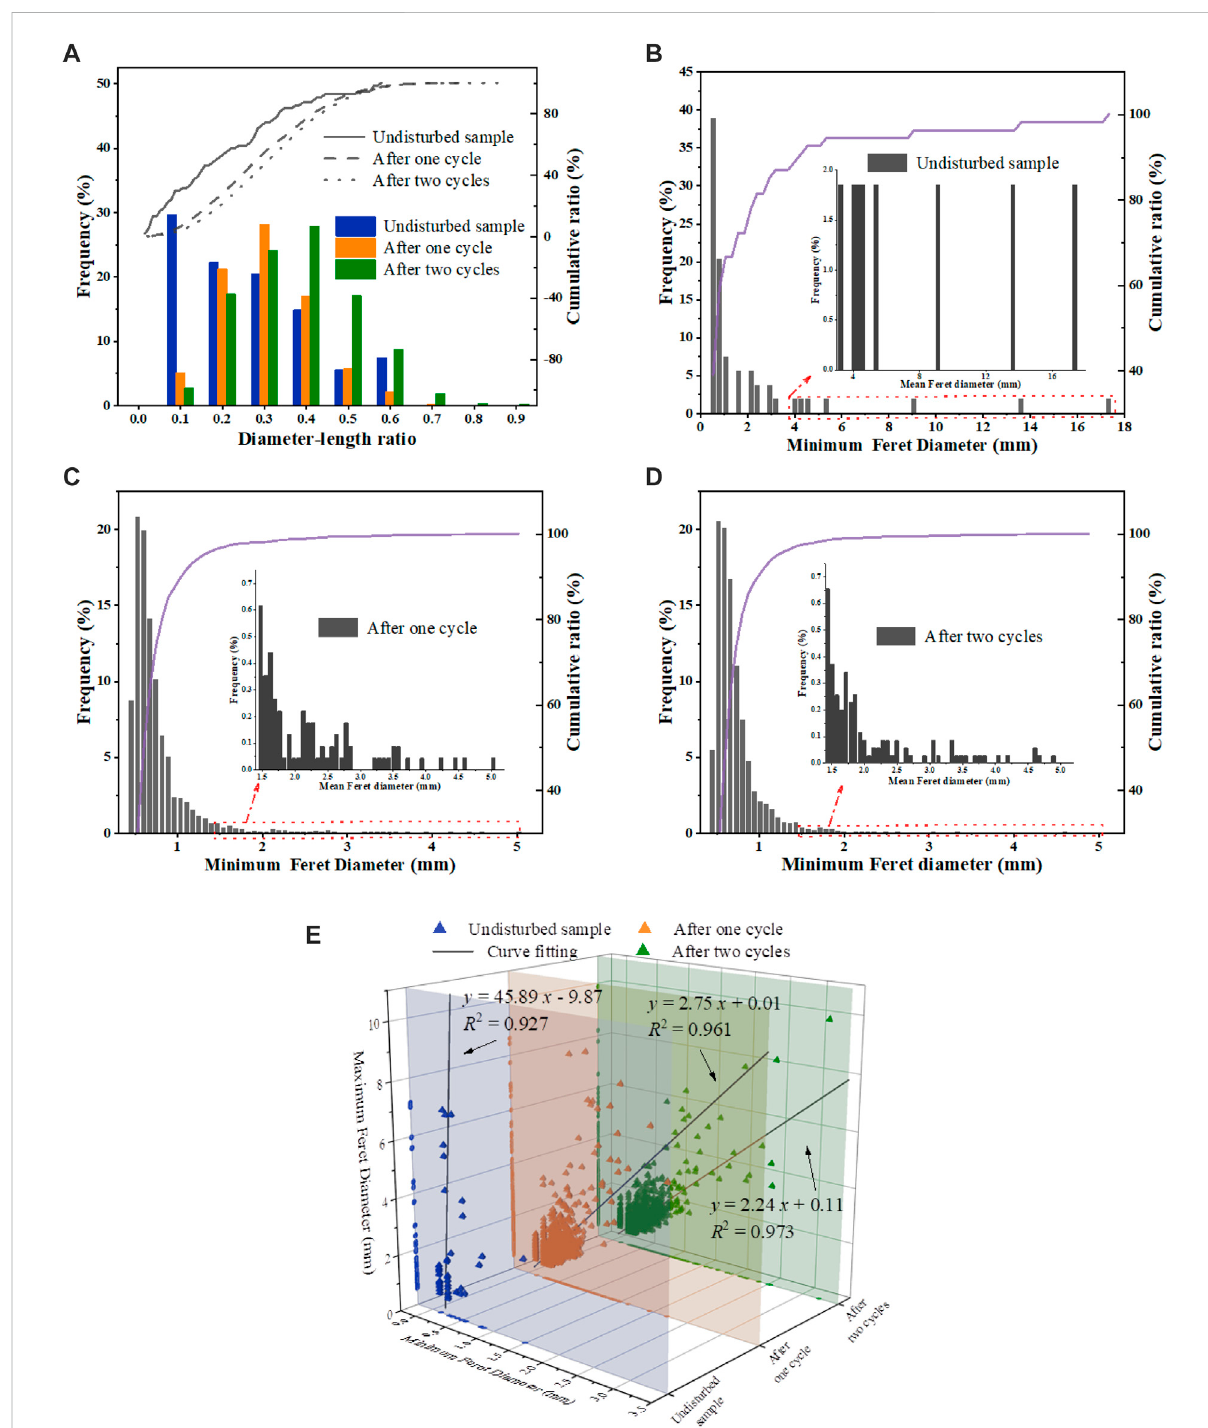
Statistics of geometric parameters. (A) Changes of diameter-length ratio; (B) Minimum Ferret diameter of undisturbed sample; (C) Minimum Ferret diameter after one cycle; (D) Minimum Ferret diameter after two cycles; and (E) Size distribution of pores: minimum Ferret diameter vs. maximum Ferret